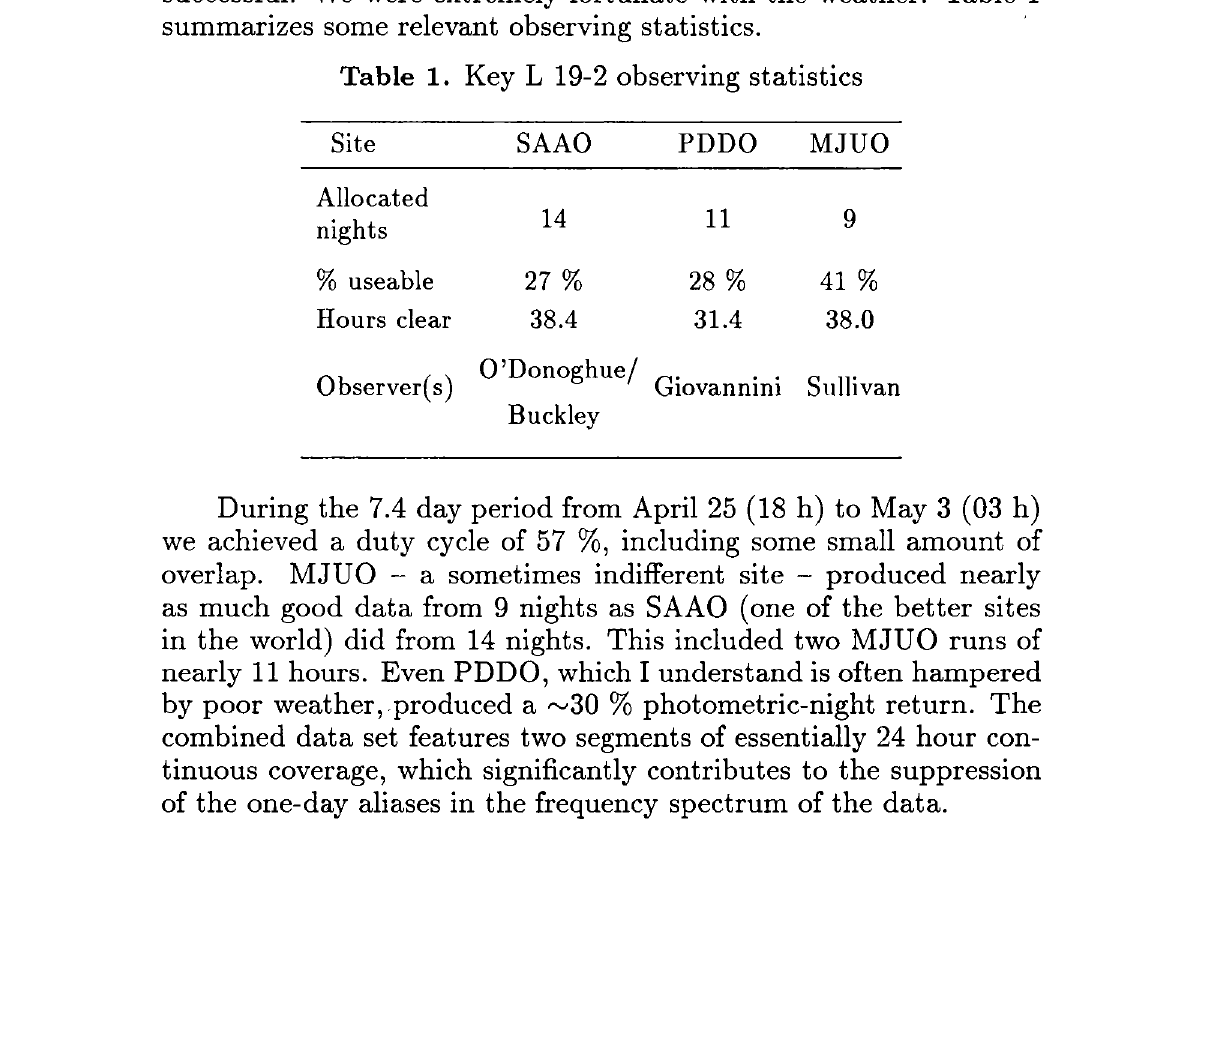
Table 1. Key L 19-2 observing